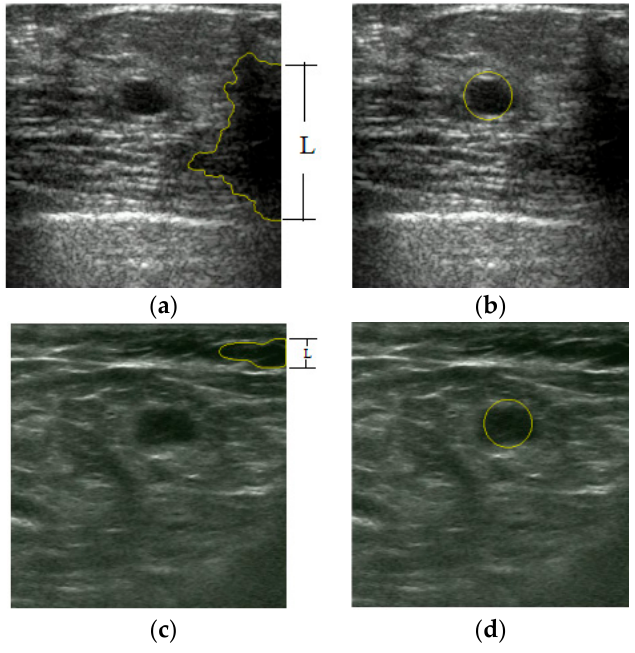
Figure 16. The localization procedures by post-processing operation. ( a ) Segmentation results from the CV level set in US Image 1; ( b ) right localization results by post-processing operation in US Image 1; ( c ) segmentation results from the CV level set in US Image 2; ( d ) the right localization results by post-processing operation in US Image 2.